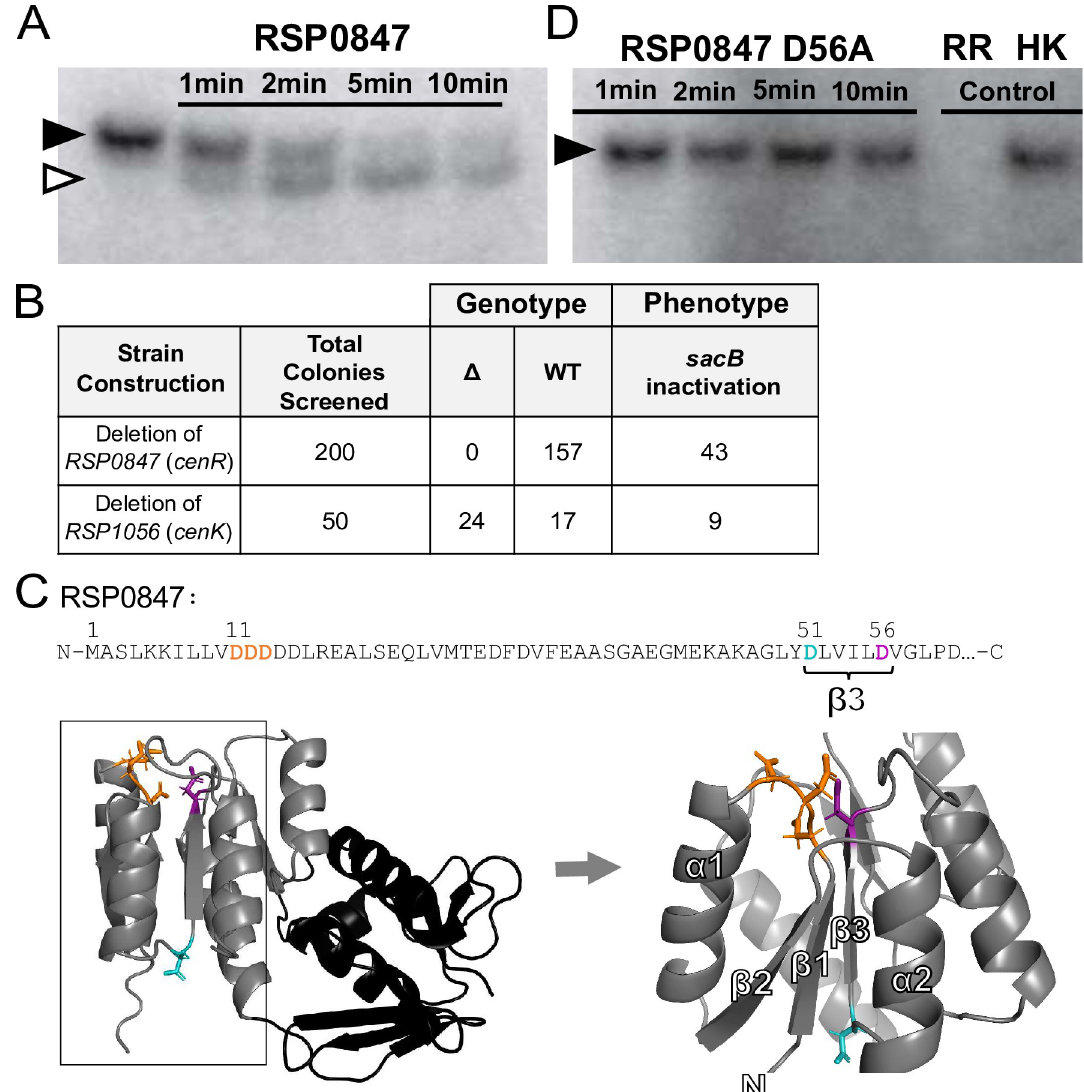
Fig 1. RSP_1056-RSP_0847 comprise an essential TCS. (A) RSP_1056 is phosphorylated after incubation with [ γ 32 P]-ATP (lane 1). When recombinant response regulator (RR) RSP_0847 was added, phosphotransfer between RSP_1056 (black arrow) and RSP_0847 (white arrow) was detected by the presence of two radiolabeled species. (B) Attempts to produce an in-frame, markerless deletion of RSP_0847 were unsuccessful. Double crossover events were scored (phenotype), and deletions confirmed by PCR (genotype). (C) Structural modeling of RSP_0847 using I-TASSER TM-align [34–36]. The RR N-terminus containing the receiver domain (grey) and C-terminal DNA-binding winged helix-turn-helix motif (black) are shown. Predicted Mg 2+ coordinating aspartate residues between α - helix 1 and β -sheet 1 (orange, D11-D13), aspartate 56 (magenta) on the C-terminal end of β -sheet 3, and aspartate 51 (cyan) on the N- terminal end of β -sheet 3, are labeled in the RR receiver domain (zoomed image). The amino acid sequence of the receiver domain, aspartates of interest, and β 3 is shown. (D) Recombinant RSP_0847 harboring an alanine substitution at aspartate position 56 (D56A) was tested for in vitro phosphotransfer from radiolabeled RSP_1056. Phosphotransfer between radiolabeled RSP_1056 and RSP_0847 (D56A) was not detected. Control reactions containing only [ γ 32 P]-ATP and RSP_0847 (lane 5) and autophosphorylated RSP_1056 incubated for 10 minutes (lane 6) are